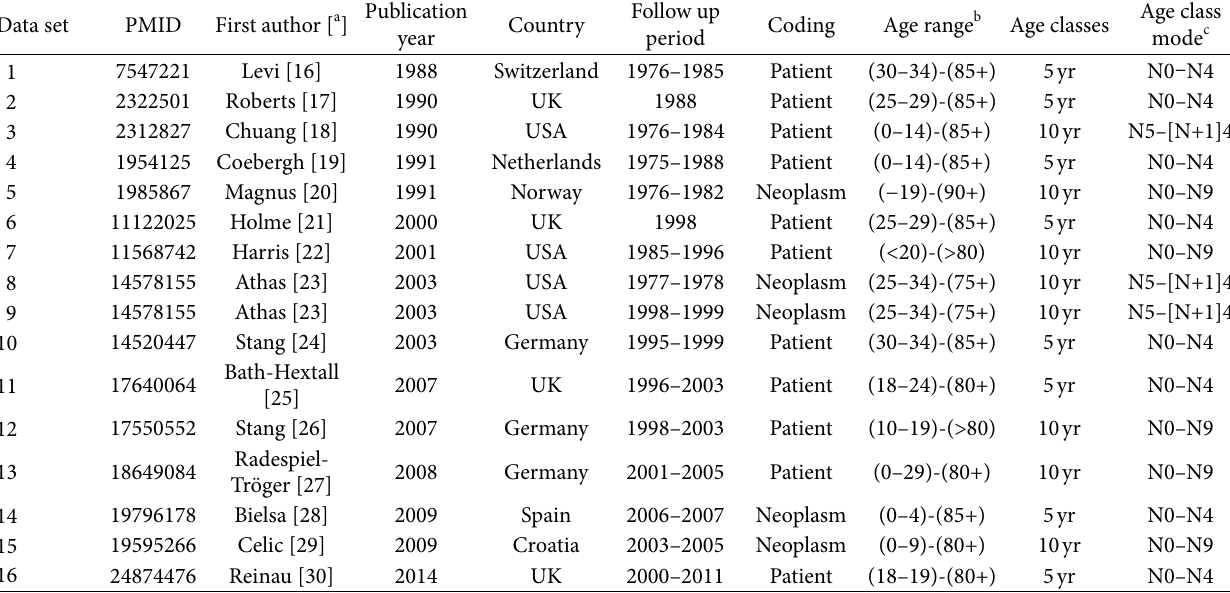
Table 2: Compilation of included data